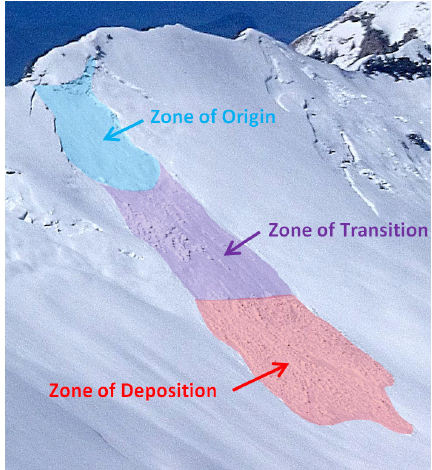
Figure 2. The avalanche activity index is the weighted sum of all reported avalanches for Switzerland (Schweizer et al., 1998, 2003). Dry-snow avalanches which started high up but were slowed down at medium altitude by wet snow are indicated as “mixed snow” in the legend. Satellite acquisitions dates are indicated by arrows. Im- ages for the multiorbital S1 composite were acquired during the gray shaded periods (see also Table A1). Figure modified after Win- kler et al. (2019).